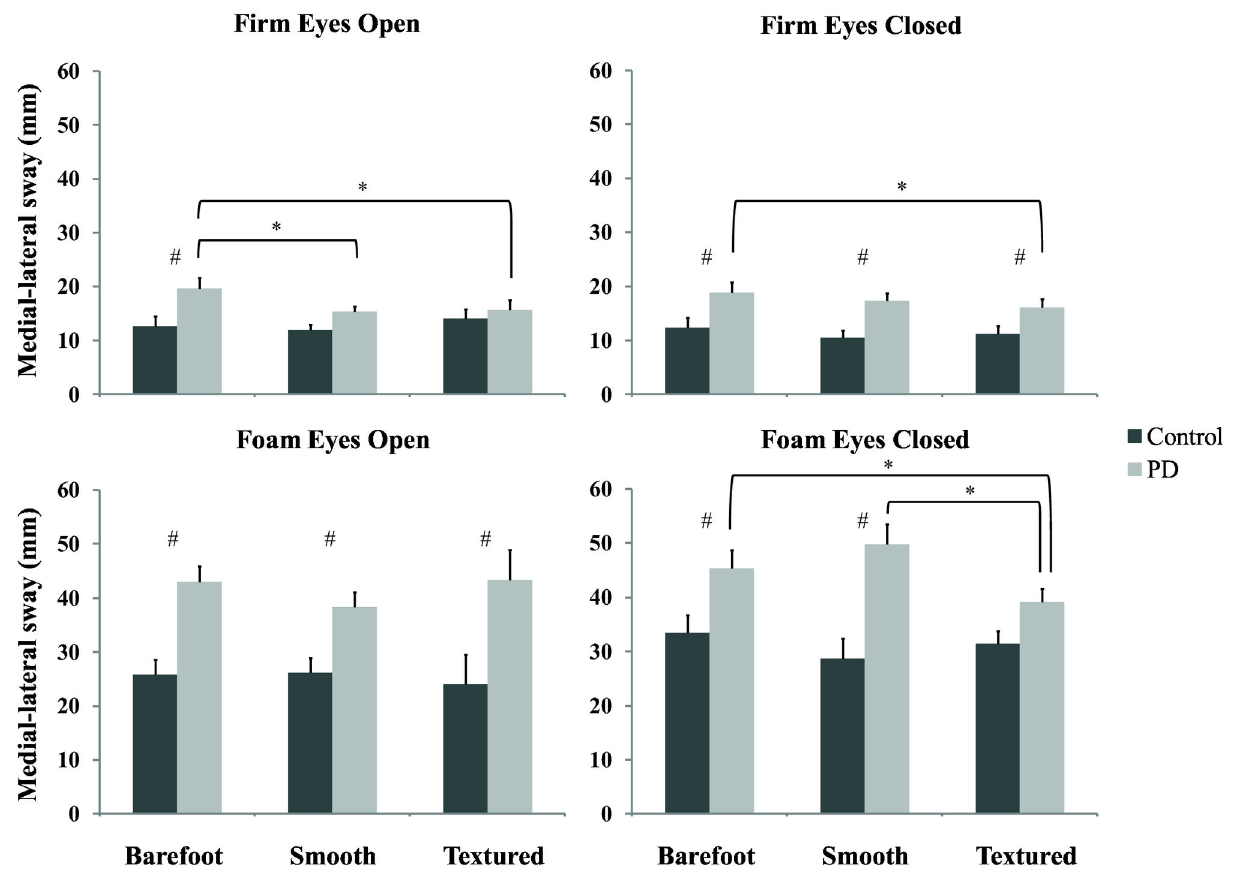
Figure 2. Mean (+1 SD) medial-lateral sway for the control (black) and PD (grey) participants under the four standing conditions. Note: # denotes a significant difference between the PD and control groups; * denotes a significant difference between the footwear conditions for the PD